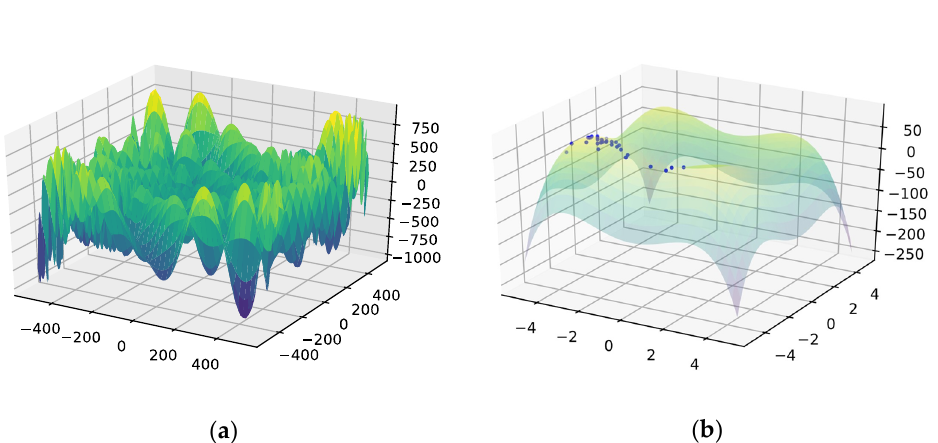
Figure 1. ( a ) Dual Eggholder function f 7 search area, which has many local extreme points. ( b ) A fish school optimizing the dual two-dimensional Styblinsky–Tang function f 2